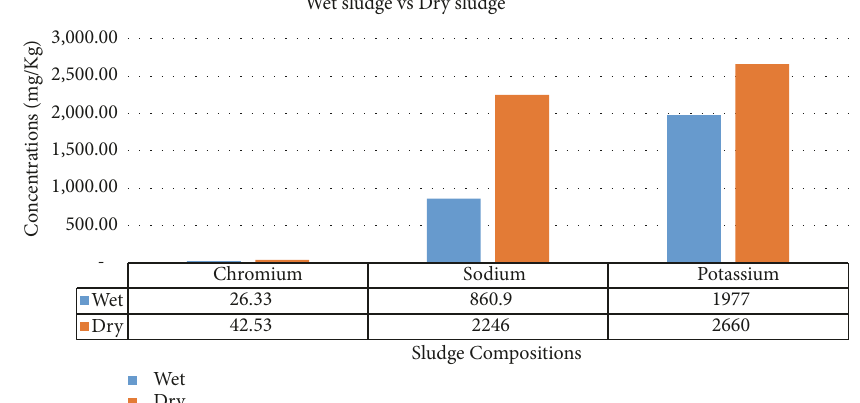
Figure 2: A graph of sludge composition having higher concentrations in dry sludge than wet sludge.